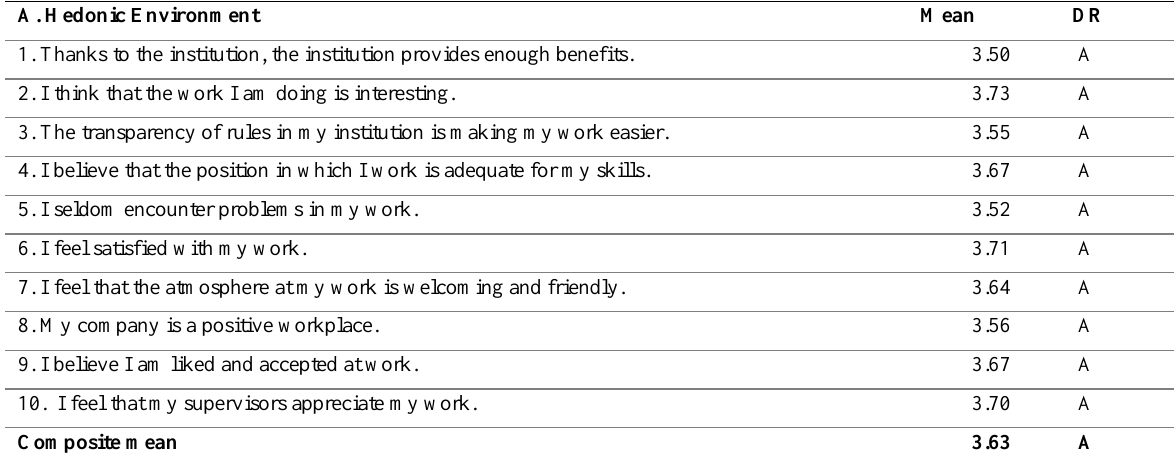
Table 6: Workplace Environment as to Hedonic Environment